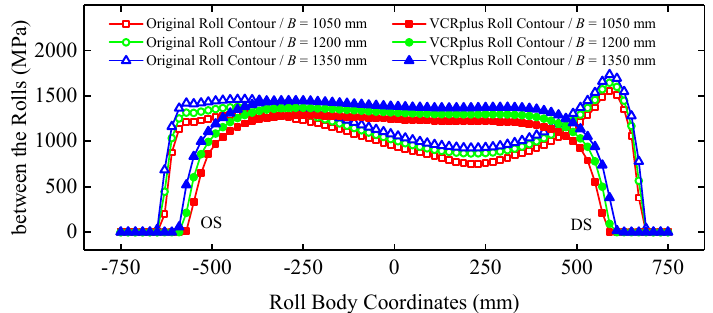
Figure 11. Comparison of the contact pressure between the rolls at different strip widths B ( S = 0 mm, q = 12.5 kN/mm).